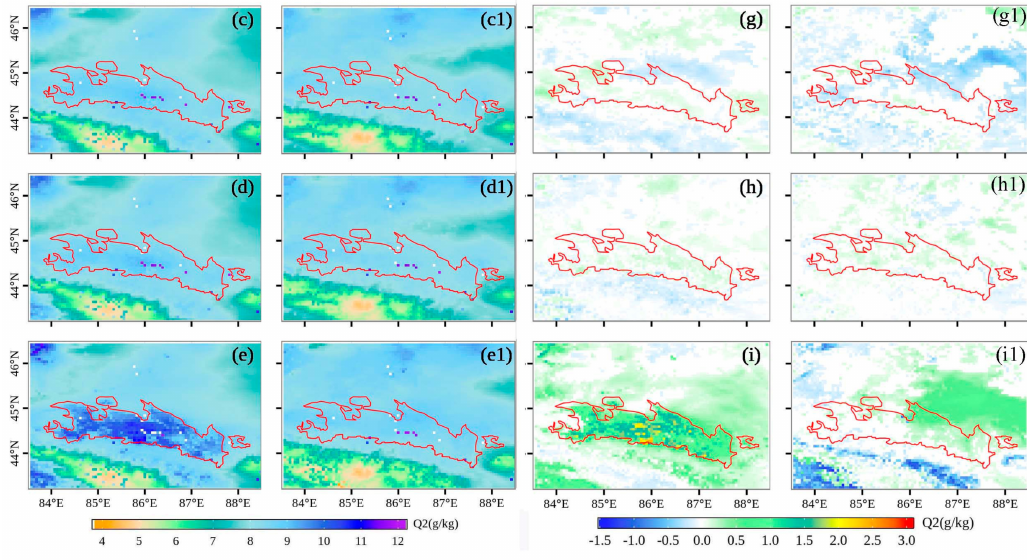
Figure 9. Daytime spatial patterns of 2 m specific humidity patterns (Q2, g kg − 1 ) from the ( a ) def, ( b ) LU, ( c ) Alb, ( d ) LAI and ( e ) VF simulations, and their differences ( f ) b–a , ( g ) c–b , ( h ) d–c and ( i ) e–d (these difference pixels are statistically significant at p < 0.05). And corresponding patterns during the night-time, which are labelled with the corresponding daytime label and the number 1. The def simulation used default LU, albedo, LAI, and VF provided by WRF itself; the LU simulation used only actual LU data; the Alb simulation used only actual LU and albedo data; the LAI simulation used actual LU, albedo, and LAI data, and the VF simulation used all of the actual terrestrial datasets. The red line represents the border of the key oasis